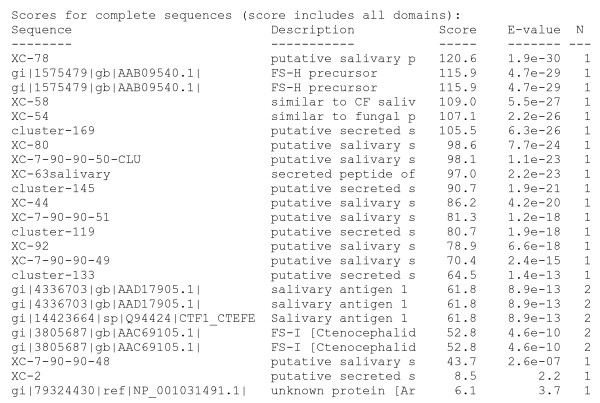
Search of the non-redundant NCBI protein database for proteins similar to flea sequences found in this work. A hidden Markov model was made from the alignment shown in Figure 6 (minus first 20 amino acids to exclude signal peptide) to search the non-redundant protein database.